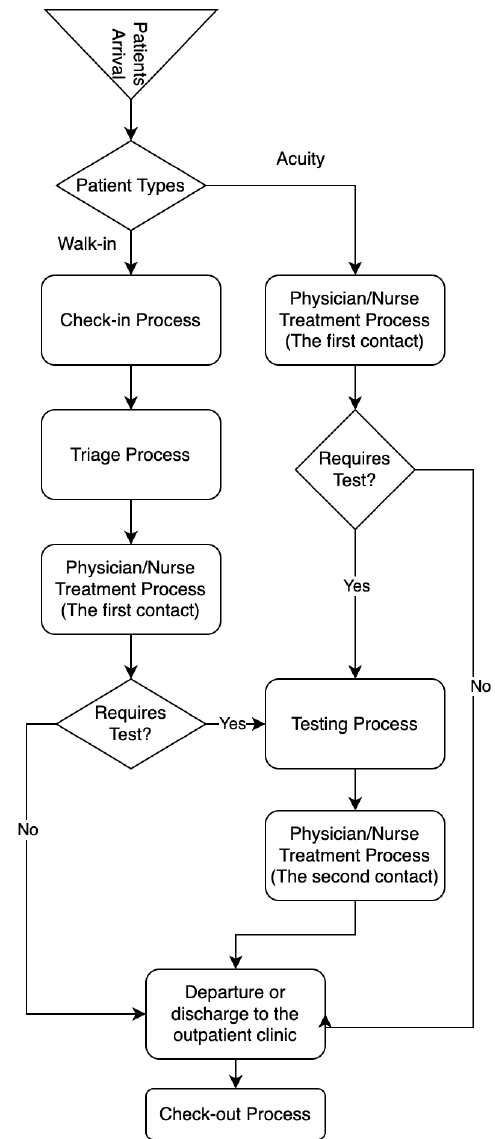
Figure 2. Patient flow chart created for the DES model. Table 3. Healthcare resources employed in the ED unit and their characteristics.